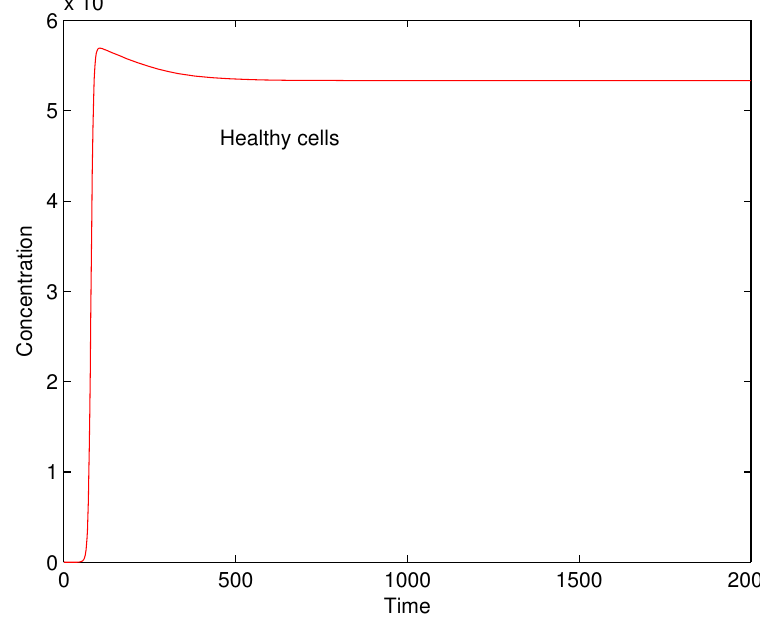
Figure 2. Concentrations of healthy cells for p id =